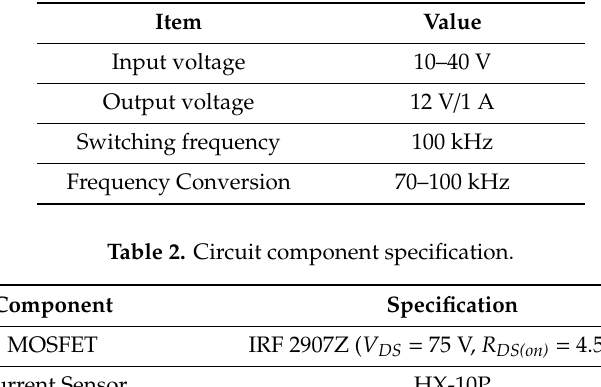
Table 1. Circuit specifications.